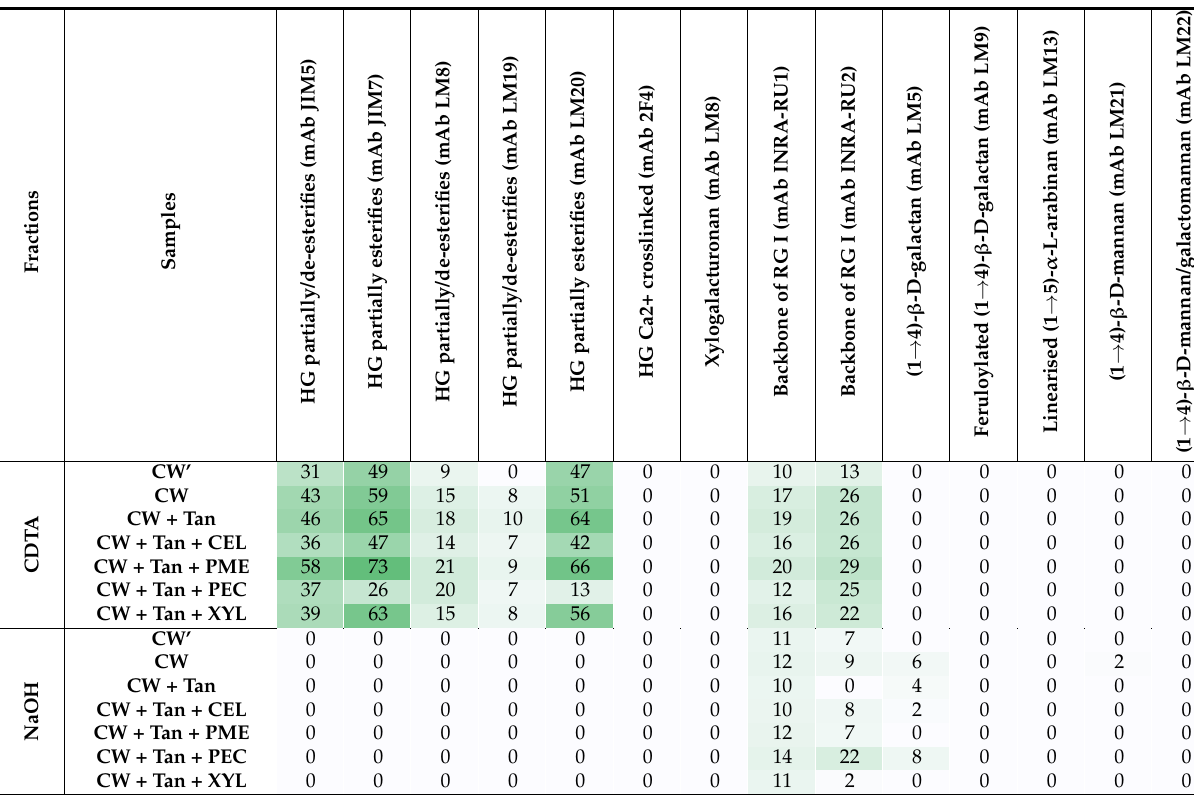
Table 3. Heatmap of epitope abundance (0–100) found in the pectin (CDTA) and hemicellulose (NaOH) fractions extracted from the grape skin cell walls of fresh (CW’) and treated (CW) grapes, after interaction with a tannin in the absence or presence of enzymes added individually to grape cell walls in an adsorption test.